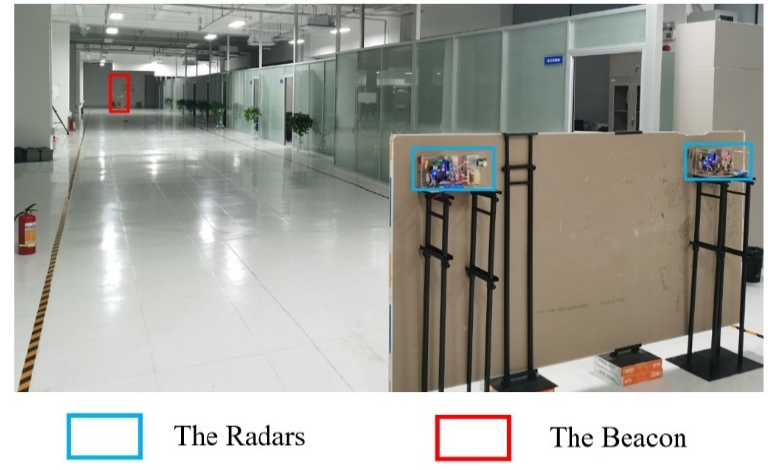
Figure 9. The type-I experimental setup. Considering the uncontrollable breathing movement of personnel, we selected the metal plate beacon as the tested object to ensure the data consistency during the collection of radar echoes. To simulate the chest movement of the human body, the metal plate beacon was controlled by a screw stepper motor to drive the metal plate to vibrate periodi- cally, as shown in Figure 10. In the type-I experiment, the metal plate beacon’s vibrating frequency was set as 0.28 Hz, and the amplitude was set as 1 cm.